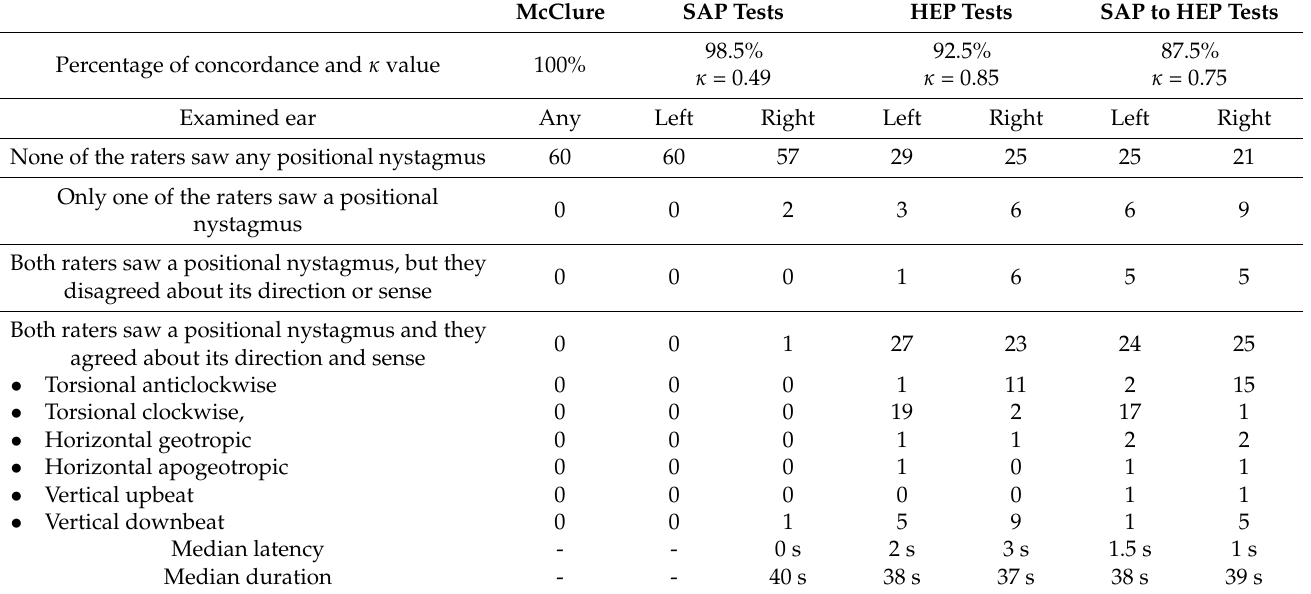
Table 2. Main results of this